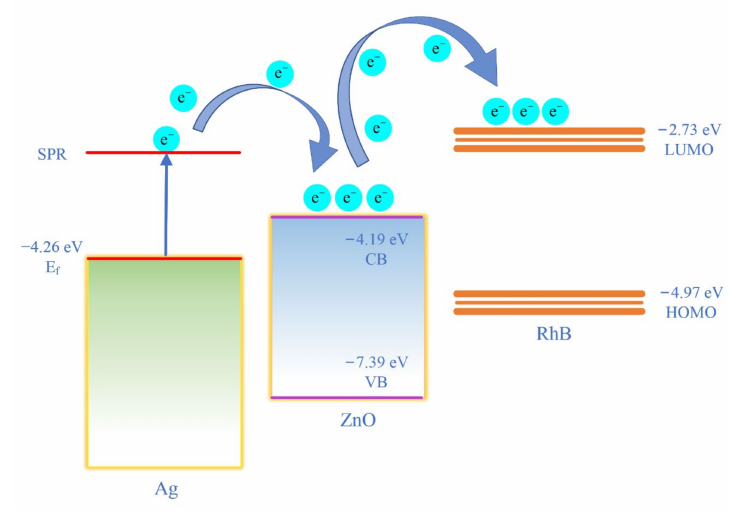
Figure 8. Schematic of CT mechanism between Ag, ZnO, and RhB.